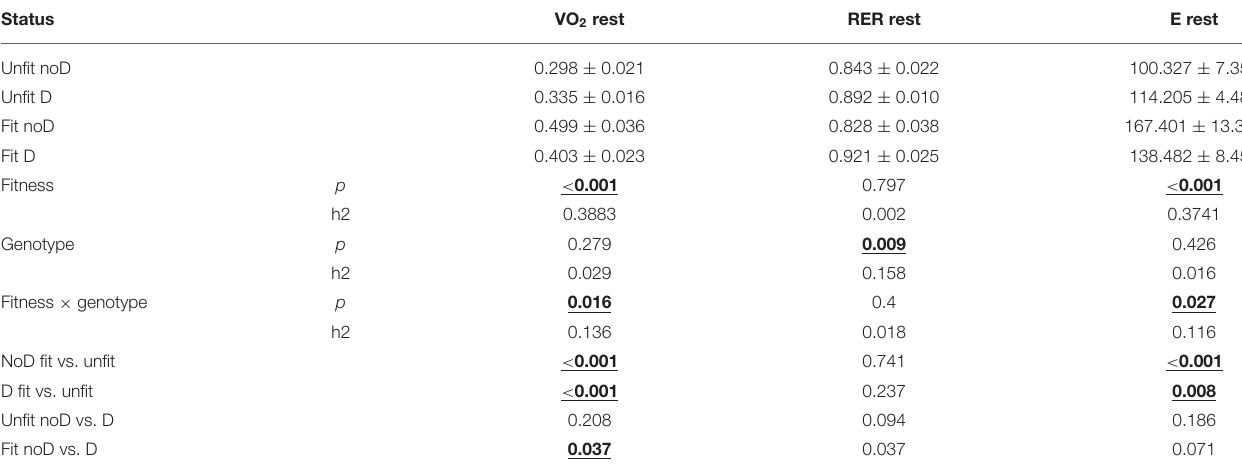
TABLE 2 | Summary of the effects of aerobic fitness and ACE-I/D genotype on oxygen dependent energy metabolism at